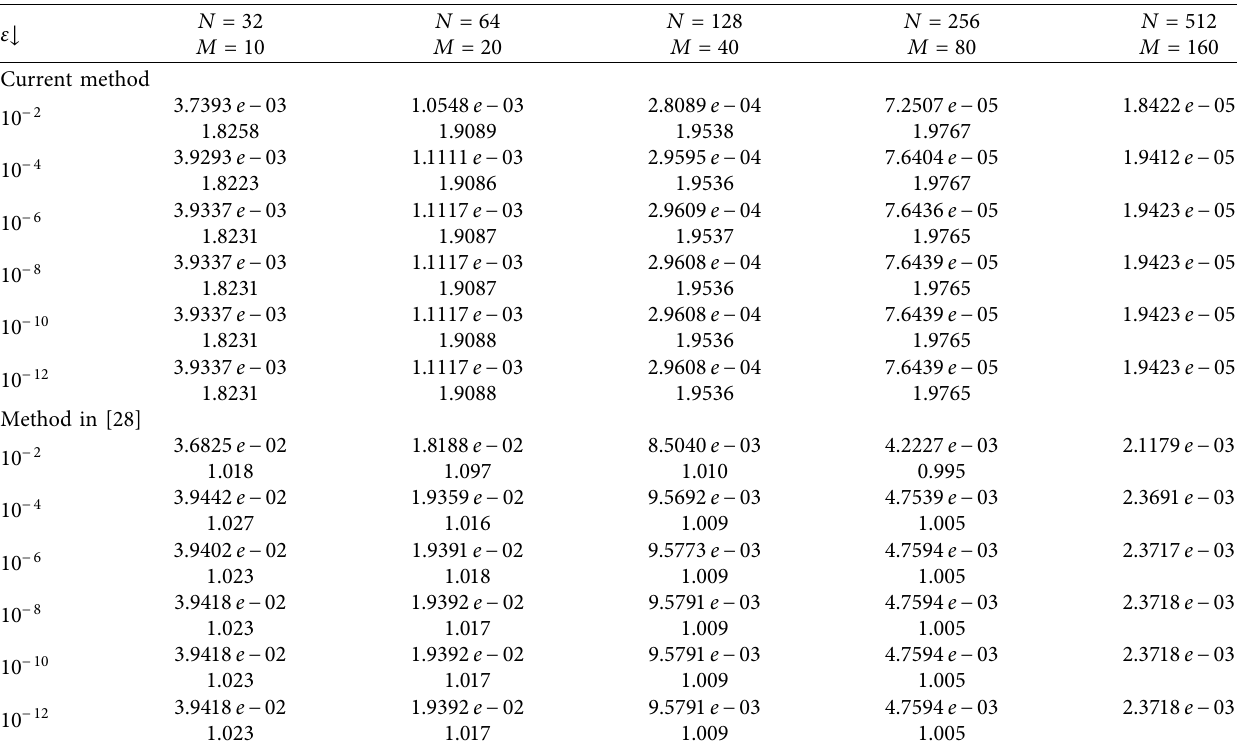
Table 2: Comparison of the maximum pointwise error and rate of convergence for Example 2 for μ � 10 − 6 and different values of ε . ε